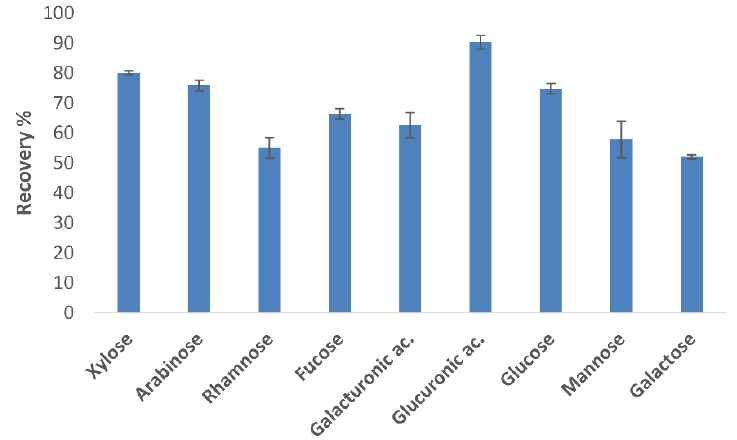
Figure 4. Recoveries (expressed as a percentage with respect to the concentration of starting solu- tion) are reported for each fraction of eluate collected from the analysis of a standard solution of 7 monosaccharides and 2 uronic acids (each at 10 ppm). The clean-up test selected, makes use of a Macherey-Nagel™ Chromabond™ NH2 Polypropylene SPE column (Experiment C). The experiment was conducted in triplicate and the error bars represent the confidence intervals.